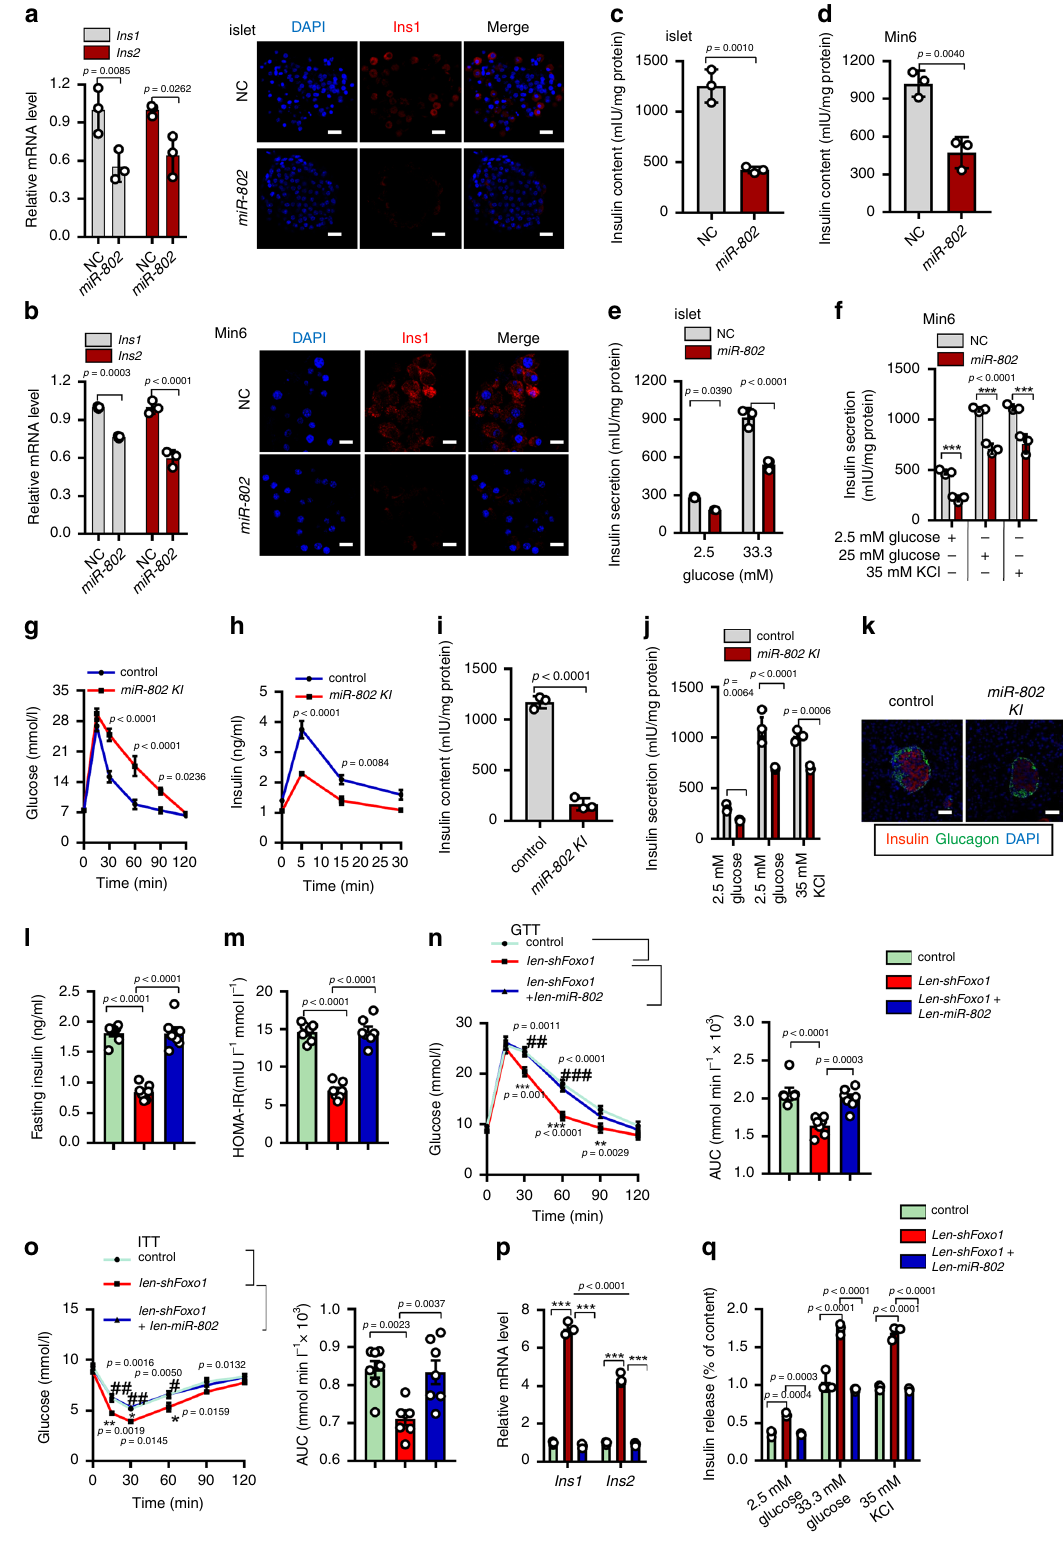
control mice at 5, 15, and 30 minutes after glucose injection (Fig. 4h, n = 7). Glucose-induced insulin secretion assays was performed in the islets of 5- and 35-week-old mice ( n = 5)